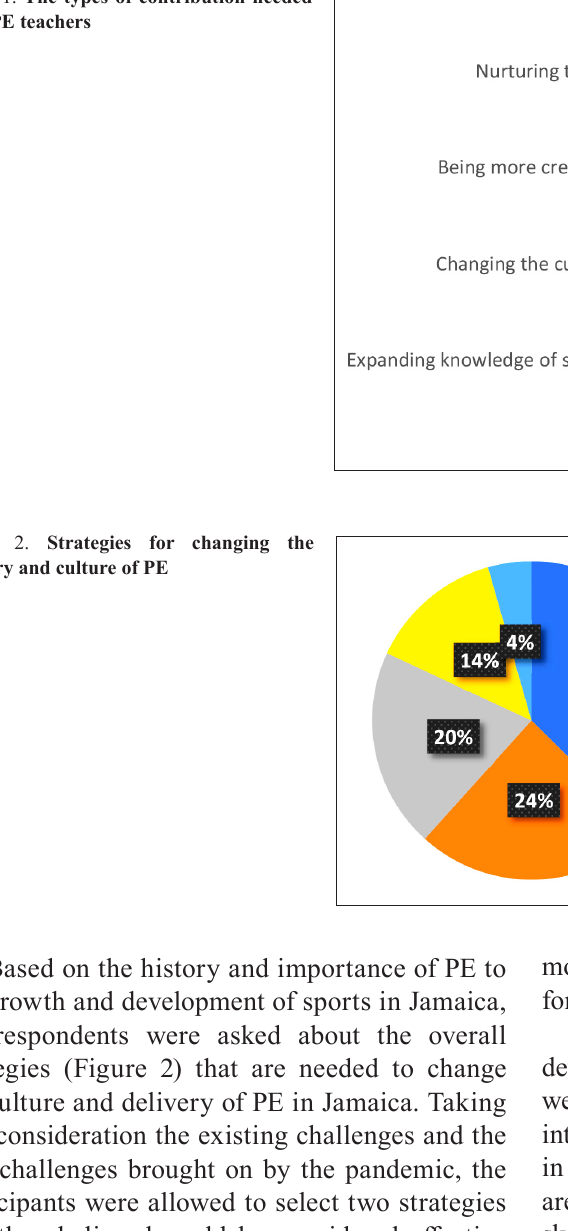
Figure 1. The types of contribution needed from PE teachers